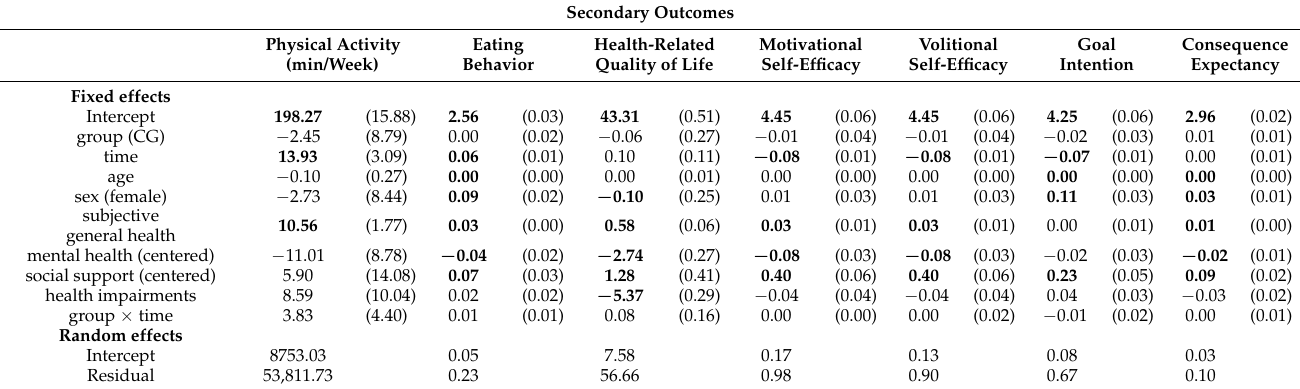
Table 3. Multi-level analyses on secondary